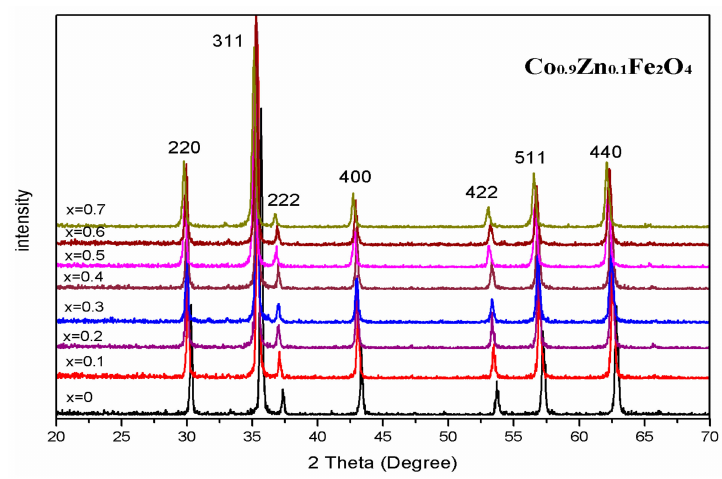
Figure 3. The XRD of Co 0.9 Zn 0.1 Fe 2 O 4 sintered at different temperatures.